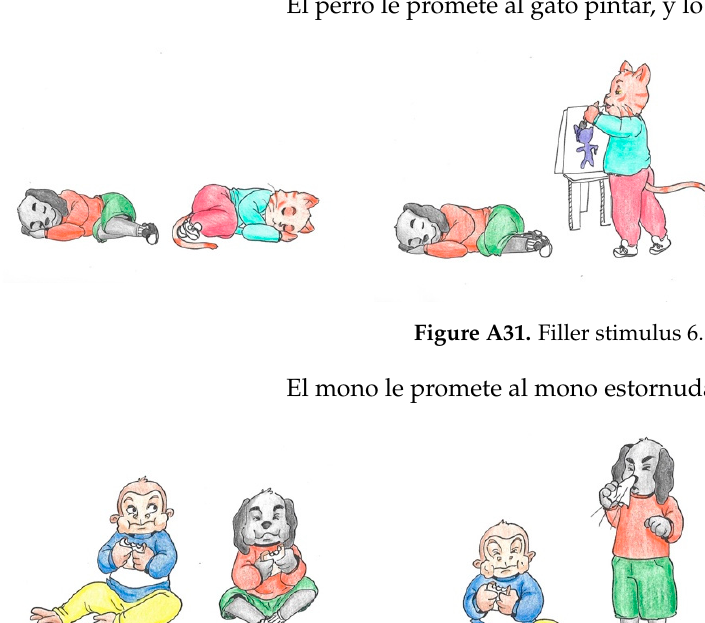
Figure A30. Filler stimulus 5.